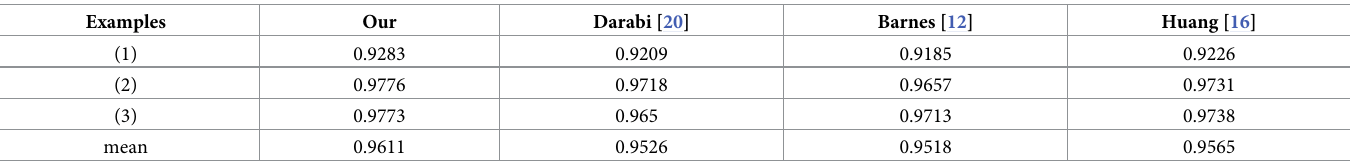
Table 2. Image completion performance of the first three images in Fig 7 measured in